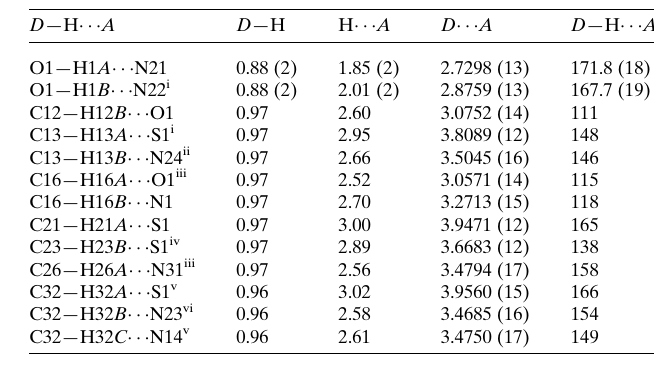
Table 2 Hydrogen-bond geometry (A˚ , (cid:4)